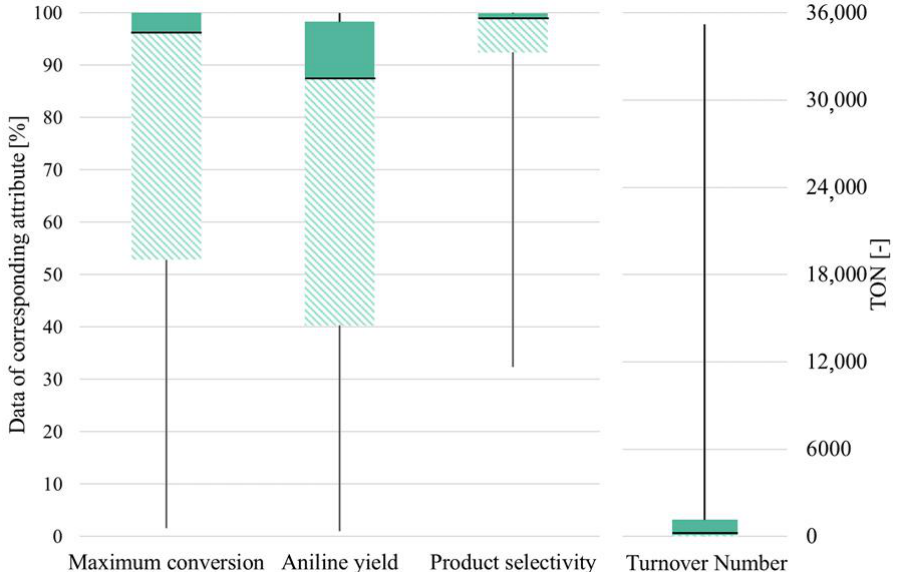
Figure 7. Relative frequency of data occurrence according to MIRA 21 descriptors.